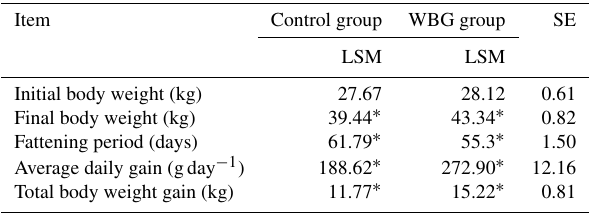
Table 4. Slaughter and carcass traits of the control and WBG lambs.